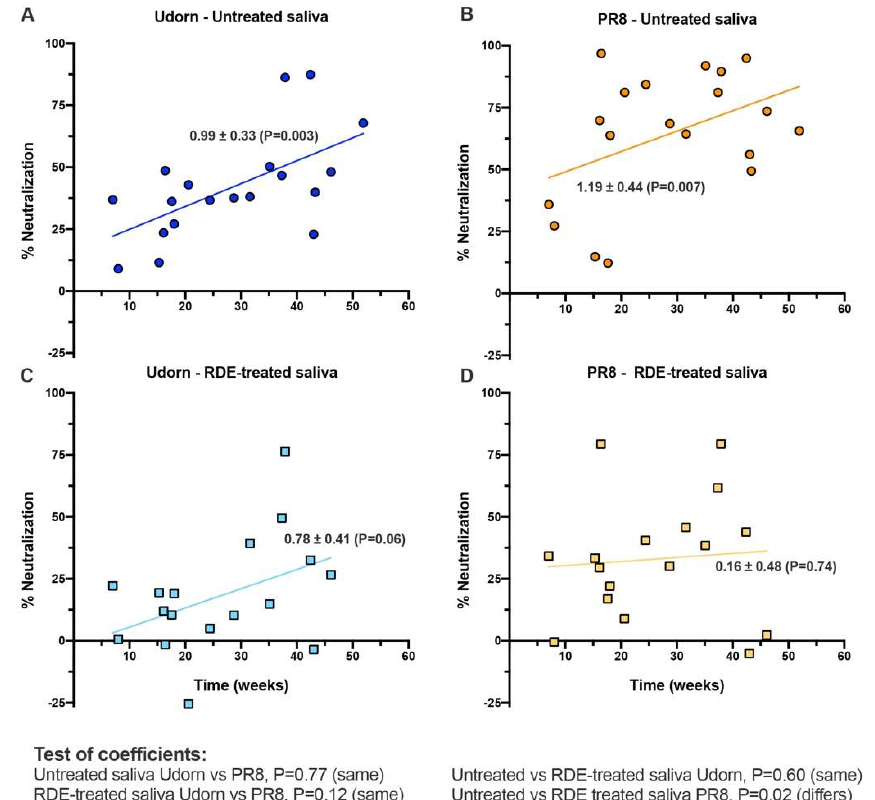
Figure 4. Effects of infant gender and age on inhibition of IAV by human saliva. PR8 or Udorn virus (5000 PFU) were added to untreated or RDE-treated saliva from ( A ) male or female infants or ( B ) infants of different ages (  or >4 months) and the percent neutralization determined as described in Figure 2. Violin plots depicting the mean of each group and probability density of the data are shown and represent the results from individual human infant saliva samples tested at least in triplicate.